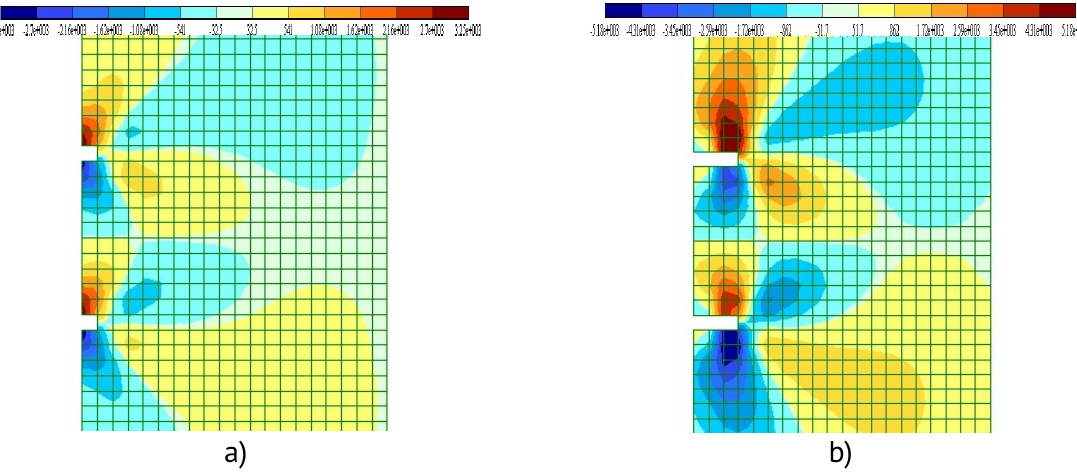
in the area with structural defect: defect depth 5 mm (а) and 15 Figure 7. Stress fields τ xy mm (b) for concrete grade С25/30 under stress in